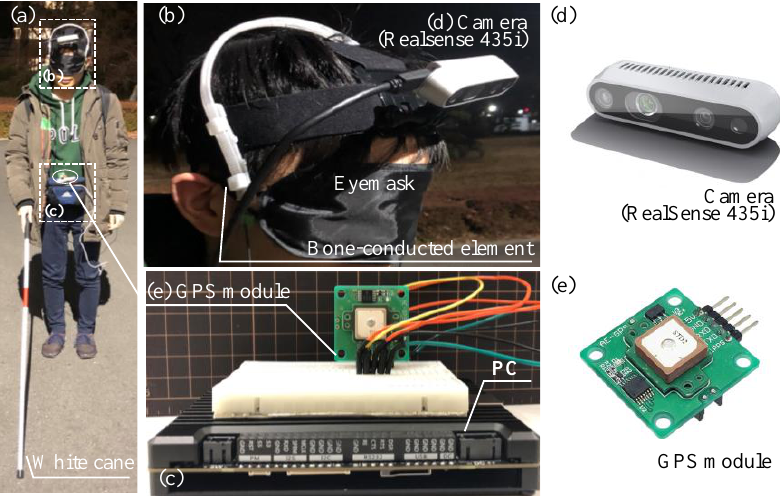
Figure 1. ( a ) Overview of the proposed navigation system, ( b ) bone-conduction device and obstacle detection device (RealSense 435i), ( c ) GPS module and PC to control the system, and devices adopted for ( d ) the detection camera and ( e ) the GPS module.